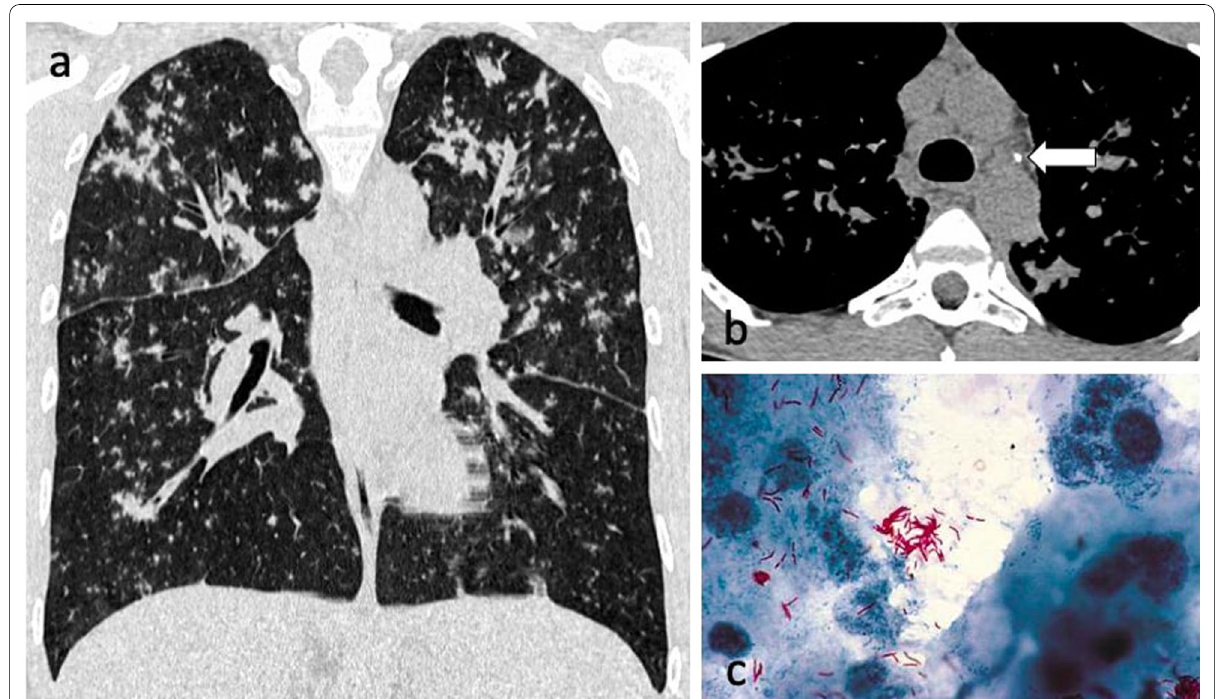
Fig. 12 A 27-year-old male with Crohn’s disease on treatment with infliximab presented with a cough that was not resolving despite antibiotic therapy. CT demonstrates extensive centrilobular and tree-in-bud nodules with a mid-upper zone predominance (lung window, coronal plane— a ). There are also small volume mediastinal and hilar lymph nodes (mediastinal window, axial plane— b ). Ziehl–Neelsen stain was positive for AFB ( c